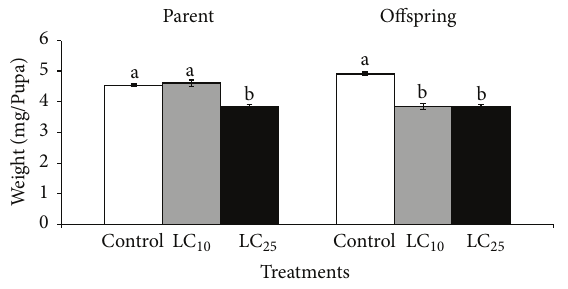
Figure 1: The effects of sublethal doses of pyriproxyfen on the pupal weight of P. xylostella in subsequent generations (parent: F (2, 72) = 10.65, 𝑃 < 0.0001 ; offspring: F (2, 72) = 10.67, 𝑃 < 0.0001 ).